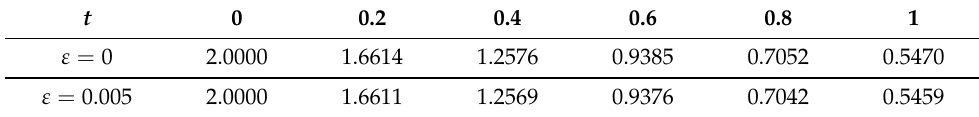
Figure 7. Simulation of UH-stability in Example 3 with (cid:101) = 0, 0.005. Table 4. Comparison of numerical solutions for the UH-stability of u ( t ) in Example